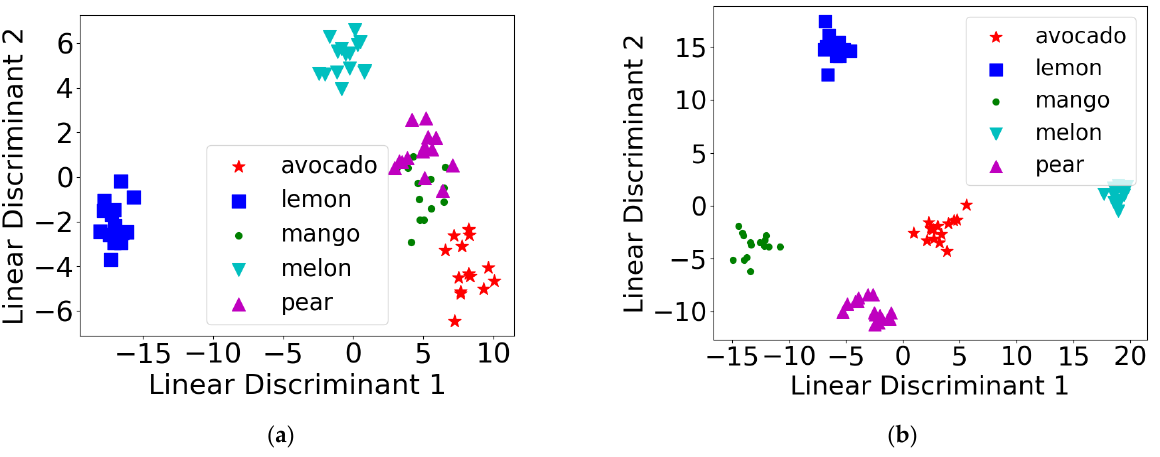
Figure 9. The LDA plot for sensors’ conductance responses of different types of fruits in the robustness dataset: ( a ) LDA plot for features extracted by equation (1) fitting, with linear discriminant 1 (LD1) accounting for 81.40% and linear discriminant 2 (LD2) accounting for 10.70%; ( b ) LDA plot for features extracted by 1D convolutional layers, with linear discriminant 1 accounting for 49.86% and linear discriminant 2 accounting for 30.29%.